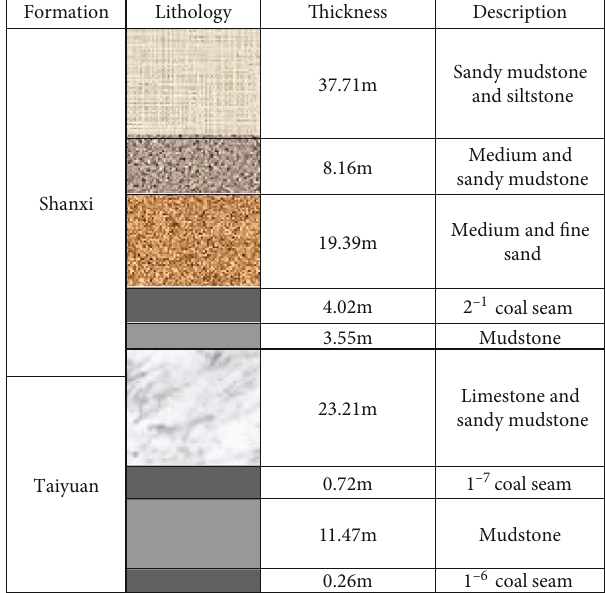
Figure 4: Comprehensive column diagrams of coal